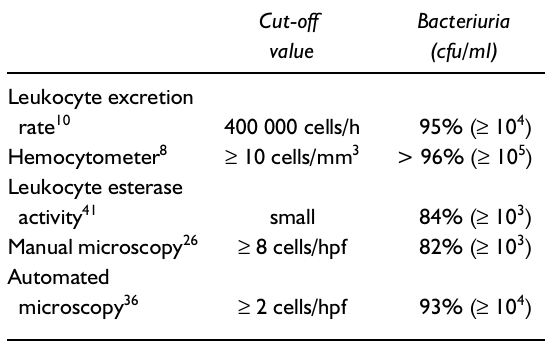
Table 2 Correlation of pyuria with